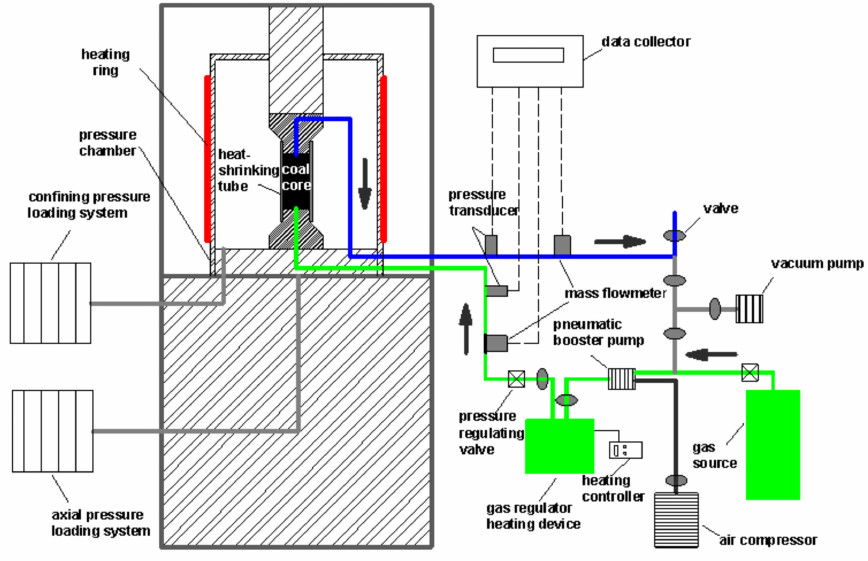
Figure 1. Schematic of the testing